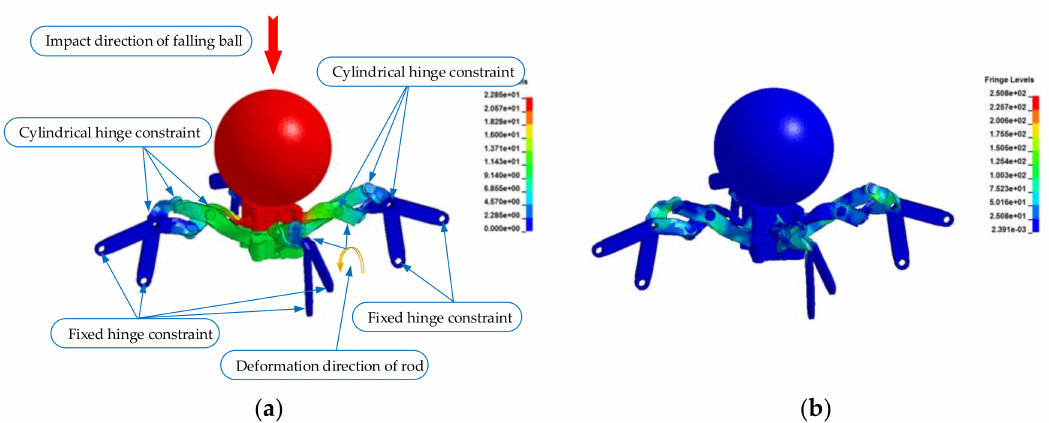
Figure 2. Simulation of the truss beam element under impact load: ( a ) Plastic deformation of the element; ( b ) Equivalent stress distribution of the